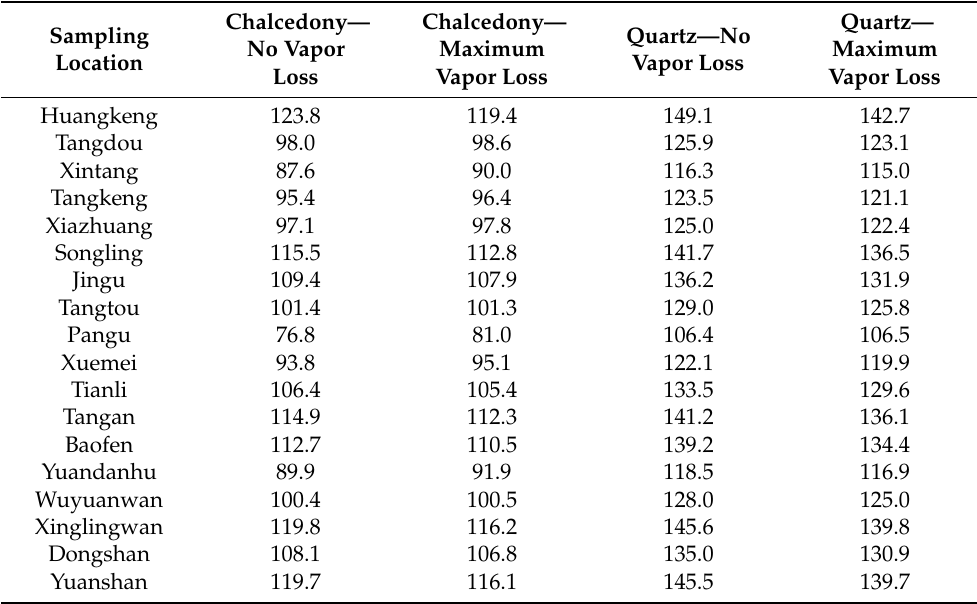
Table 2. Geothermal reservoir temperature for different geothermal systems in the study area by the SiO 2